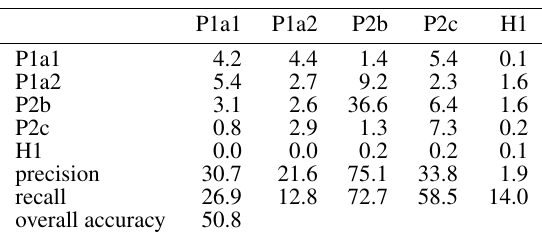
Table 2. Accuracy assessed with the sampling and validation scheme SS. Confusion matrix normalised by the number of total objects. Precision, recall, and overall accuracy (%) are calculated using area-weighted accuracy assessment.